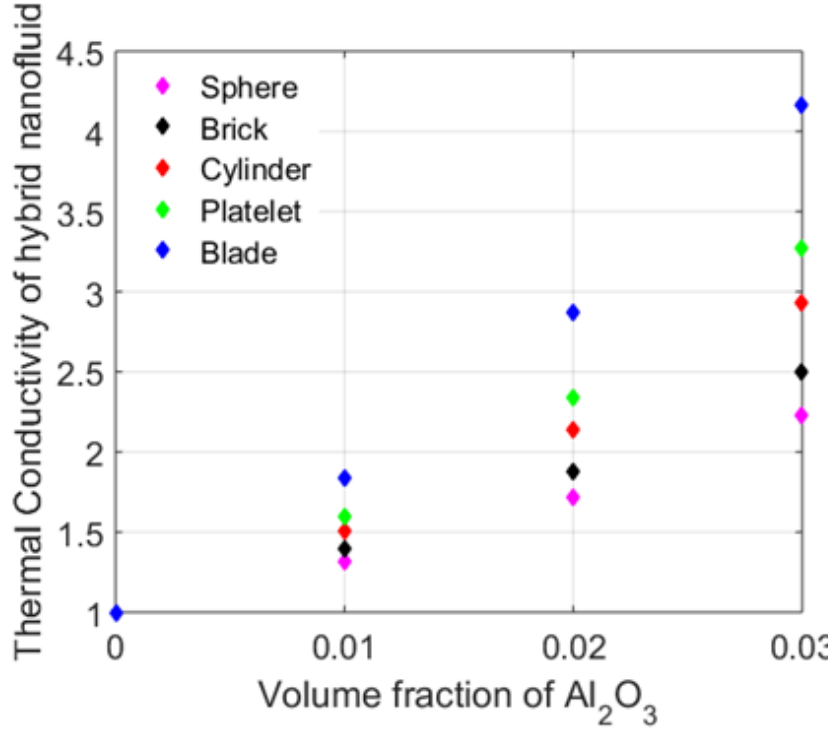
Figure 3. Thermal conductivity of the hybrid nanofluid for various nanoparticle shapes.